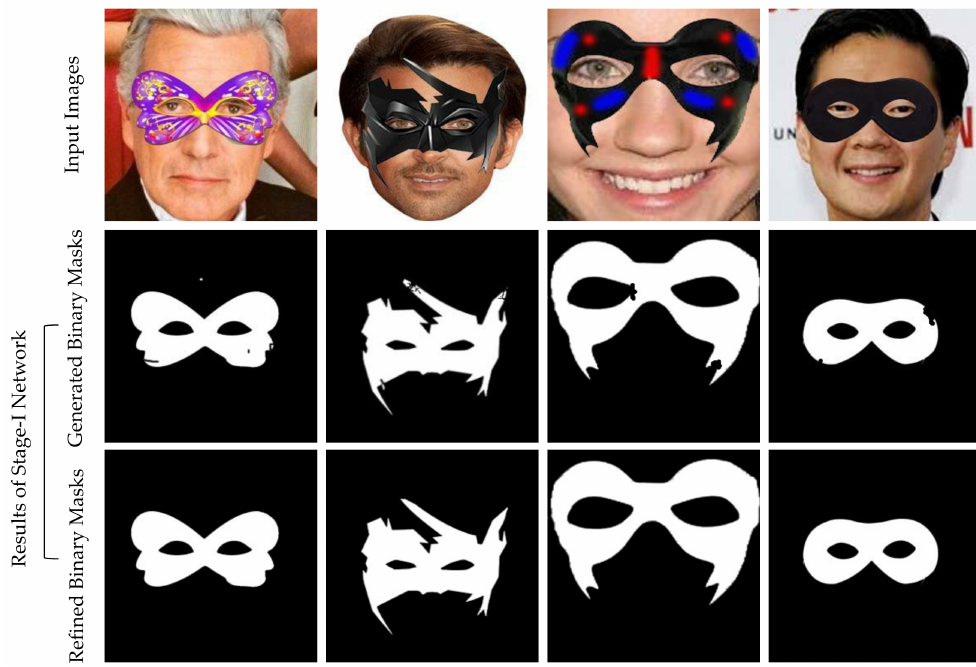
Figure 4. The results of Stage-I Network on real-world